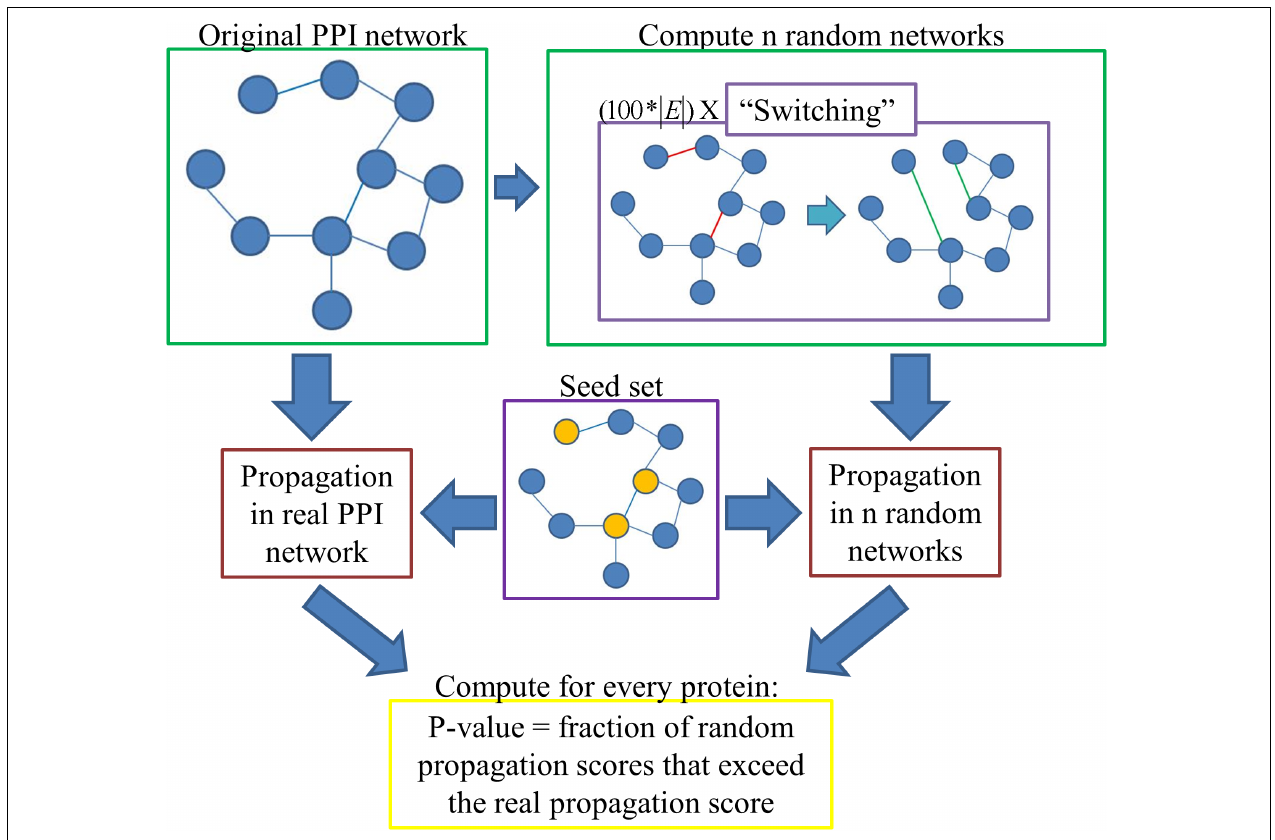
FIGURE 1 | Schematic pipeline of the RDPN